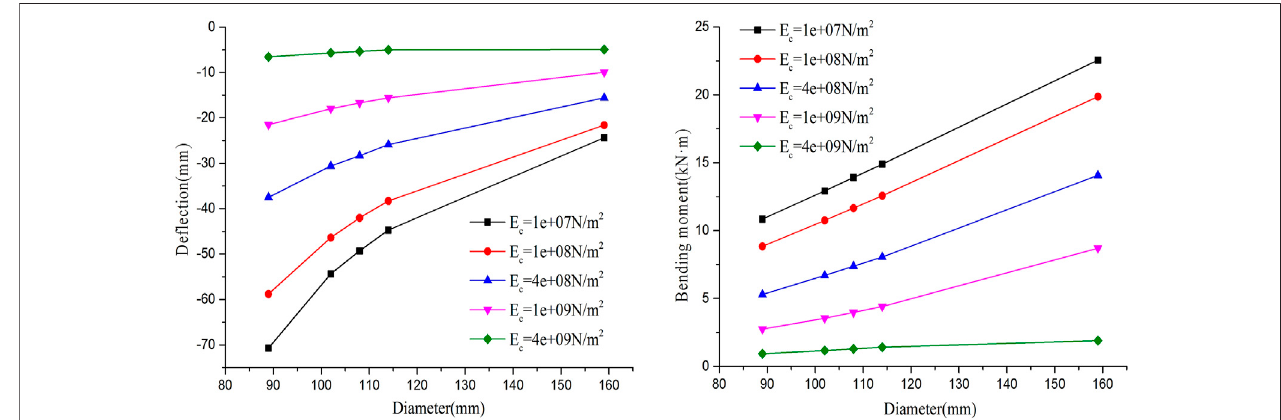
FIGURE 14 | The relation between the diameter of the steel pipe and de fl ection and bending moment under different elastic moduli of reinforcement.